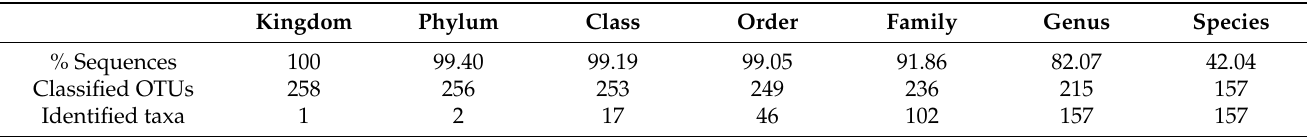
Table 1. Overview of grapevine fungal microbiota